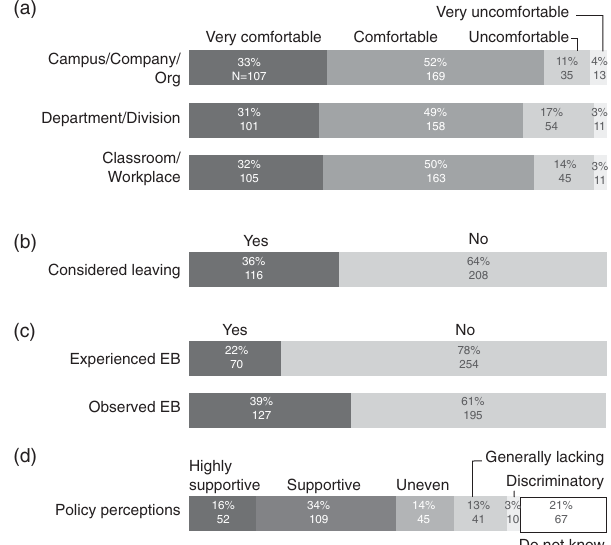
FIG. 3. Participant perceptions of overall climate. (a) Comfort in different institutional contexts. (b) Whether participants had considered leaving. (c) Experience and observation of exclu- sionary behavior. (d) Perceptions of institutional policies.